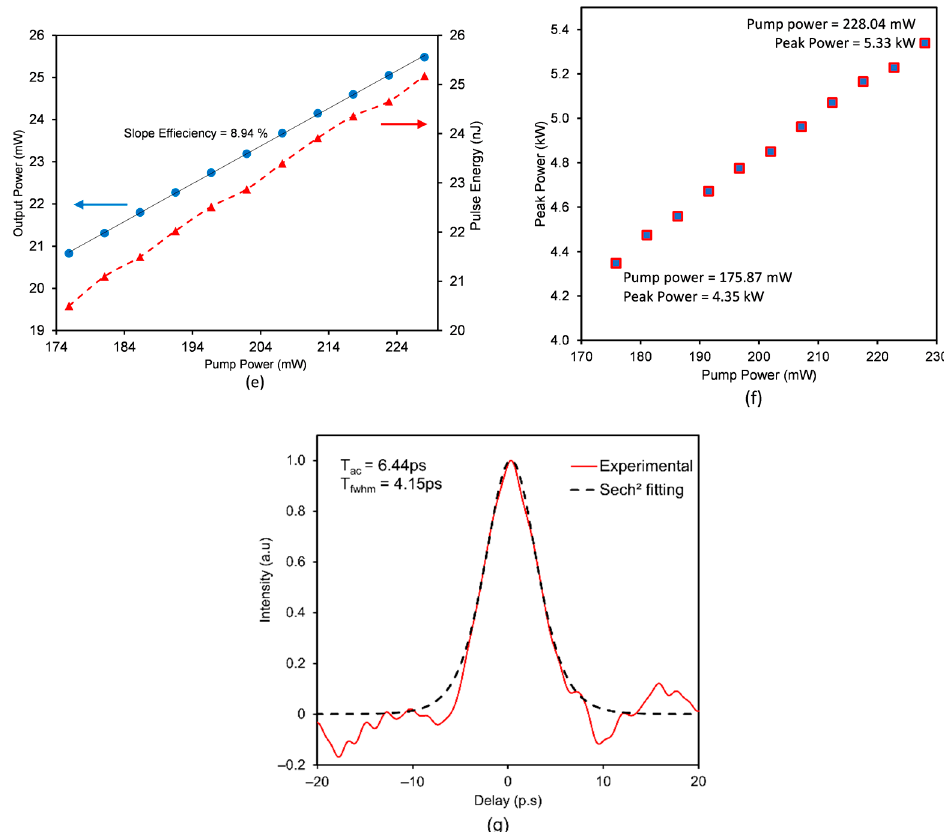
Figure 4. Mode-locked pulse performances: ( a ) the Y 2 O 3 -PVA SA output spectrum at a pump power of 228.04 mW, ( b ) the enlarge of peak-to-peak with the constant frequency, ( c ) pulse train of the oscilloscope, ( d ) the RF spectrum at the pump power 228.04 mW, ( e ) the output power and pulse energy as a function of pump power, ( f ) peak power against pump power from 4.35 kW to 5.33 kW, and ( g ) the intensity against delay with 4.15 ps FWHM.